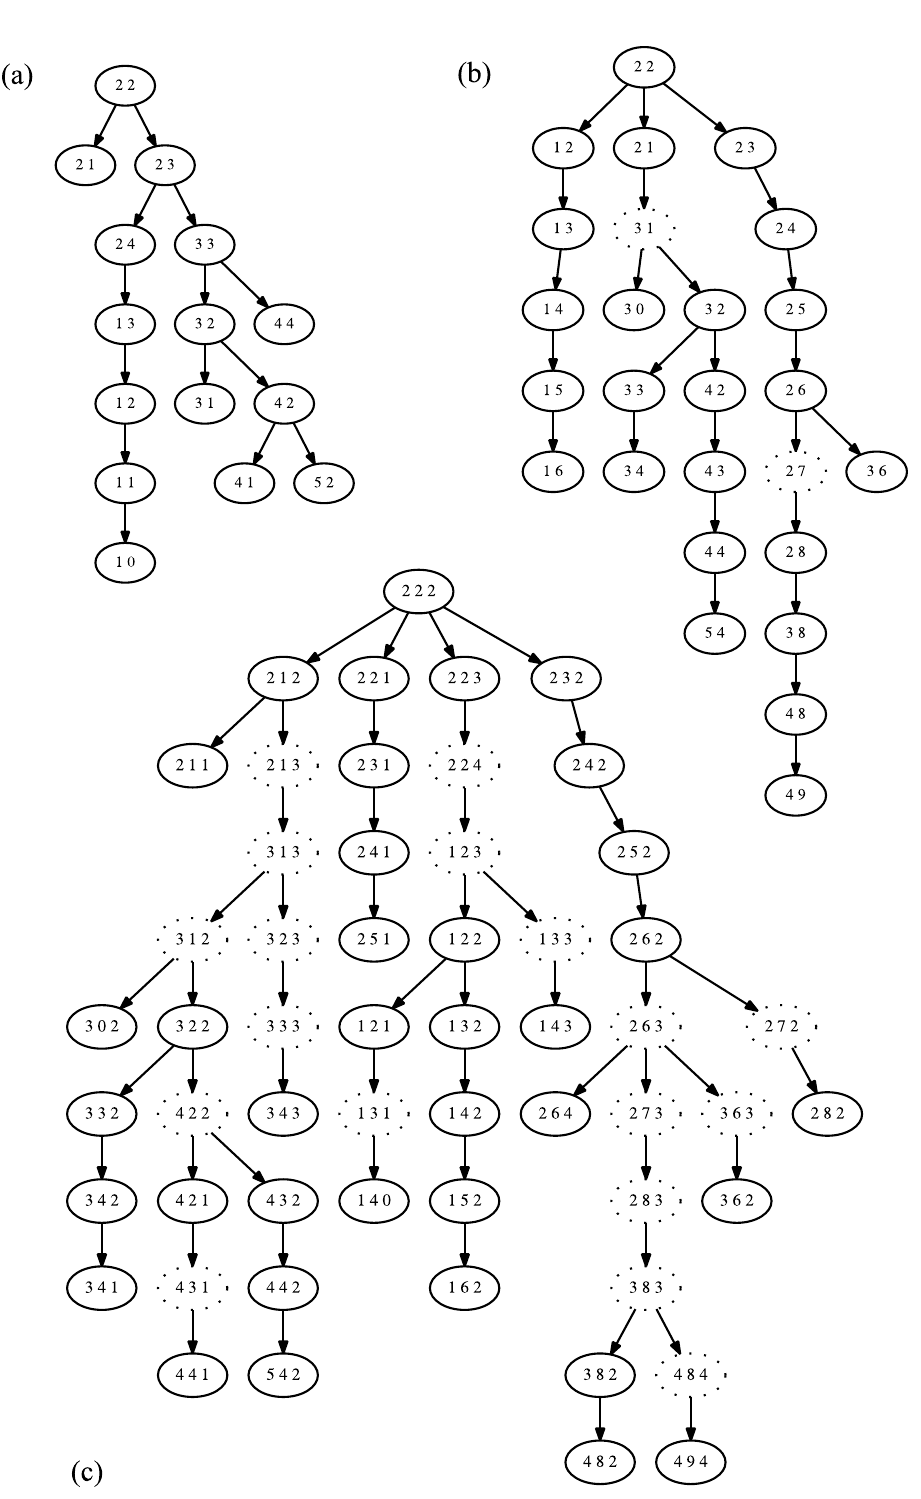
Fig 2. Illustrative example of two single gene trees and a merged tree for a single tumor sample. All trees derive from the BC patient 9 IDC sample. (a) Single-gene tree derived from the CCND1 gene probe and the ploidy probe. (b) Single-gene tree derived from the MYC1 gene probe and the ploidy probe. (c) Merged tree for CCND1 and MYC derived from the single-gene trees of (a) and